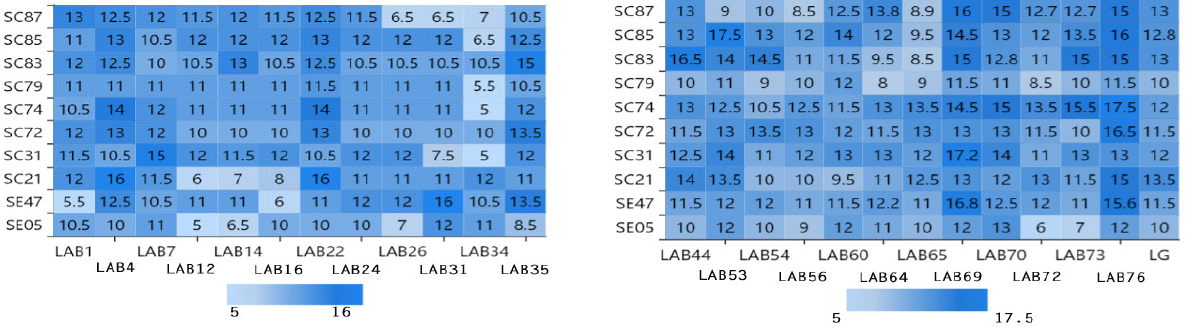
Figure 1. Experimental results of inhibitory zone of 24 Lactobacillus isolates to 10 Salmonella isolates. Note: The vertical axis is 10 strains of Salmonella , the horizontal axis is 24 strains of Lactobacillus , and the intersection of the horizontal axis and the vertical axis is the diameter of inhibition zone of Lactobacillus inhibiting Salmonella . (The diameter of inhibition zone: mm).